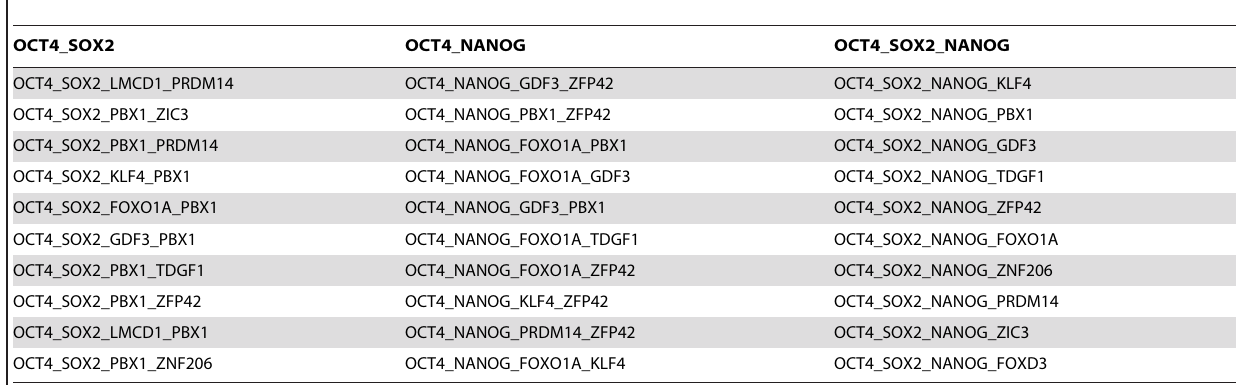
Table 2. Top 10 candidate reprogramming recipes in each composition of master regulators.